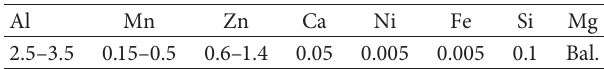
Table 1: Chemical composition of as-cast AZ31 magnesium alloy ( ω